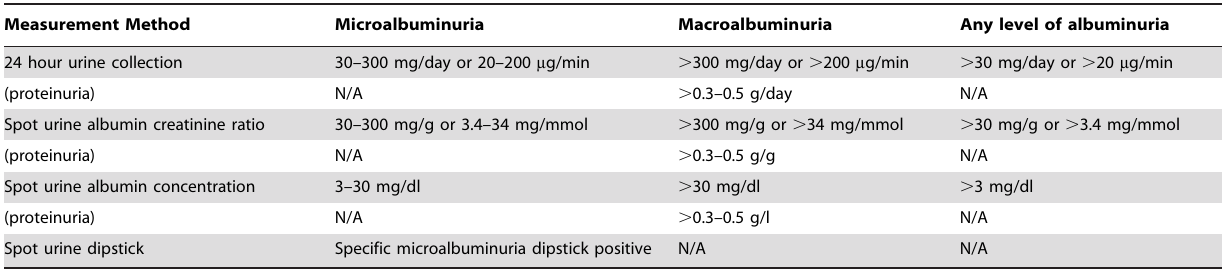
Table 2. Definitions of